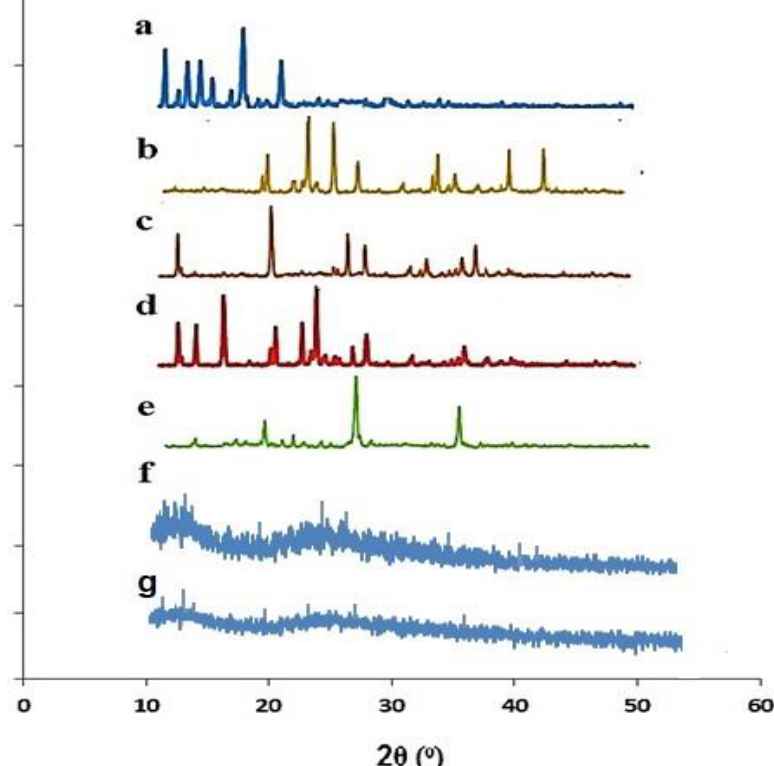
Figure 2. PXRD patterns of ( a ) pure drug docetaxel (DTX), b β -CD, ( c ) Carboxymethyl chitosan (CMC), ( d ) AMPS, ( e ) physical mixture, ( f ) DTX loaded β CD-co-poly (AMPS), and ( g ) DTX loaded β CD-CMC-co-poly (AMPS) nanosponges.